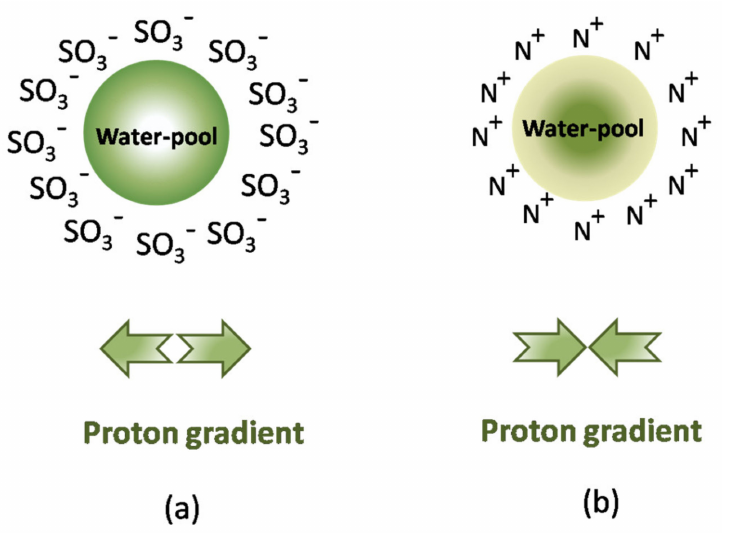
Figure 7. Proton gradient inside the water pool of the reverse micelle of ( a ) an anionic surfactant (e.g., AOT), and ( b ) a cationic surfactant (e.g.,